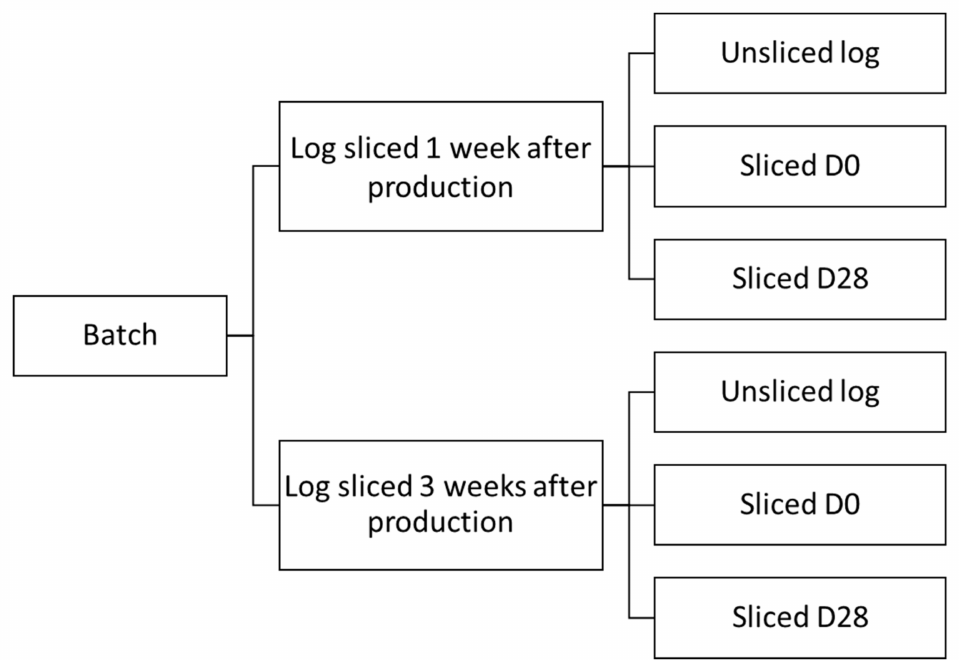
Figure 1. Schematic overview of sample collection procedure, resulting in six samples per batch. This scheme is applicable for each of the product types (per product type, five batches were